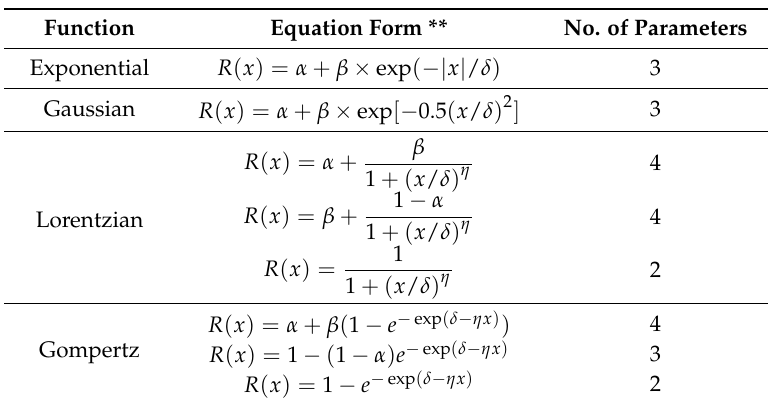
Table 1. Mathematical functions used for fitting scattering profiles